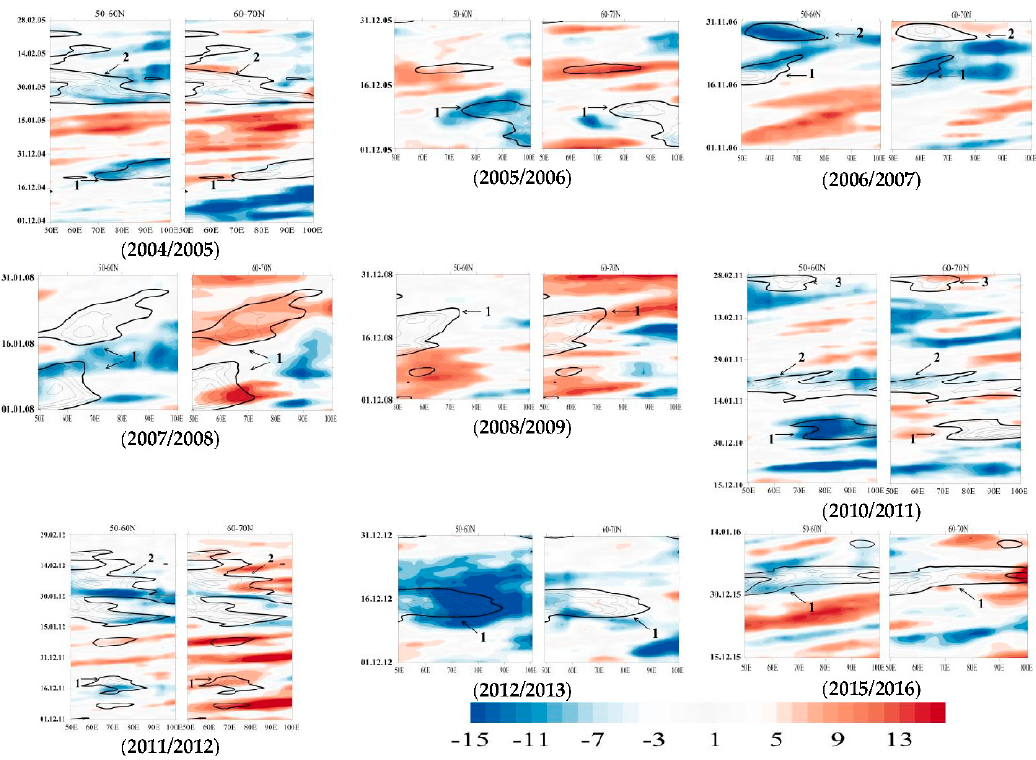
Figure 3. Time-longitude cross sections of the surface temperature anomalies and GHGS > 0 (black solid line) for 14 winter blocking events over Western Siberia.